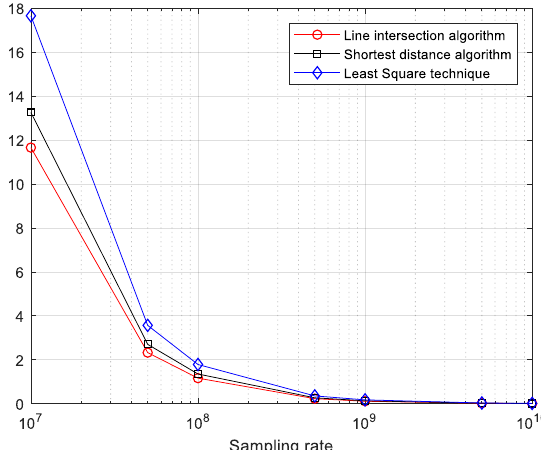
Figure 9. MSE of MS position estimation using the shortest distance and the line intersection algorithms for the first case.